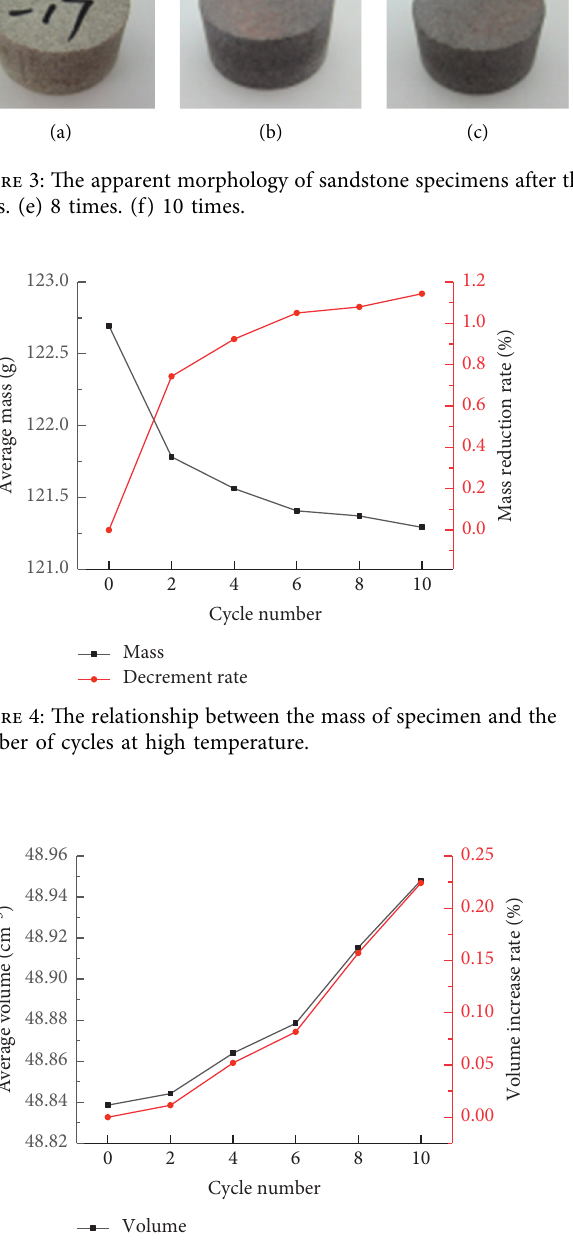
Figure 7: The relationship between the longitudinal wave velocity and the number of cycles at high